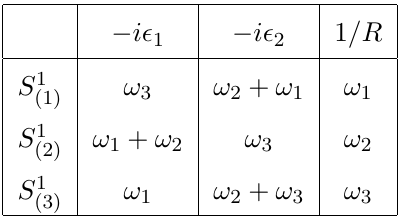
Table 4. Identi(cid:12)cation S 5 squashing parameters - gauge theory ! 1 ;! 2 ;! 3